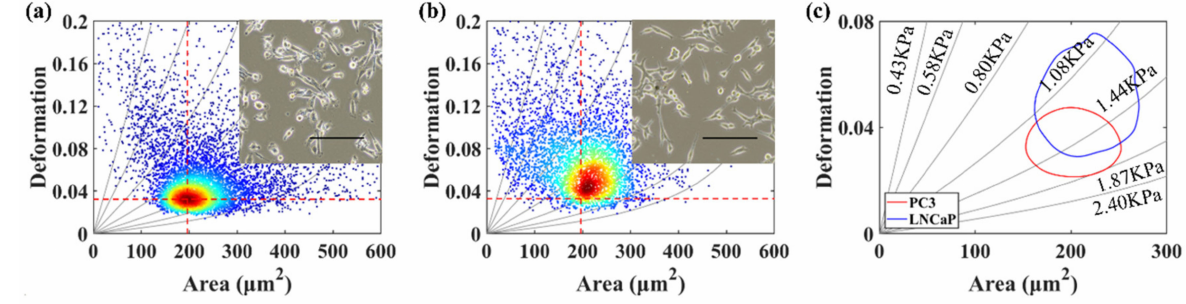
Figure 4. ( a ) The deformation versus area scatter plots of PC-3 cells. ( b ) The deformation versus area scatter plots of LNCaP cells. ( c ) The 50% density contour line of PC-3 and LNCaP cells. The red dotted lines for references represent the median of PC-3 cells’ cross-sectional area and deformation. The inset shows the optical microscopic images of PC-3 and LNCaP cells. The scale bar represents 200 µ